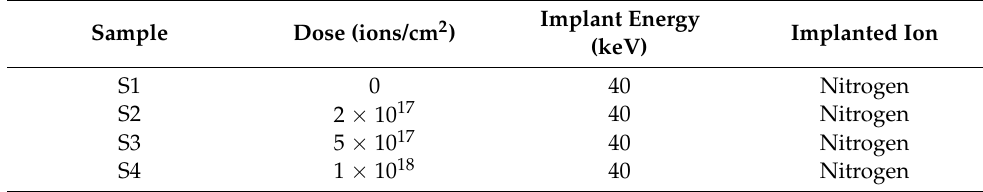
Table 1. The parameters of the ion implantation process.